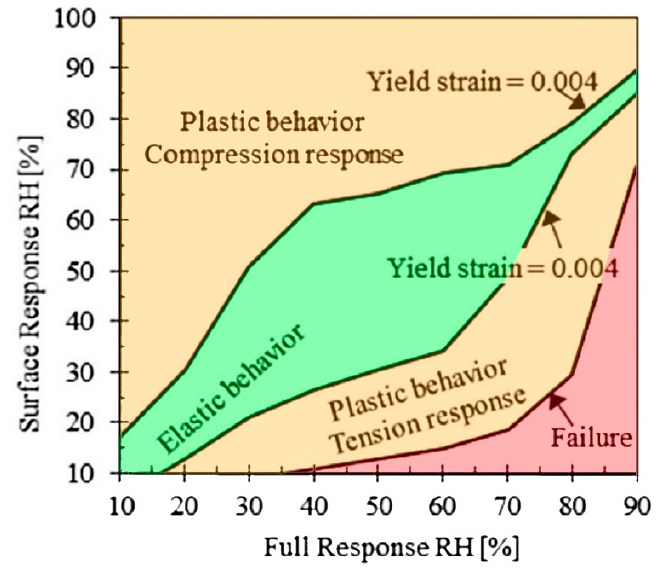
Figure 3. Mechanical risk assessment for the wooden support of paintings. The green, orange and red areas indicate conditions with a low, medium and high risk of deterioration respectively. Adapted from [58].